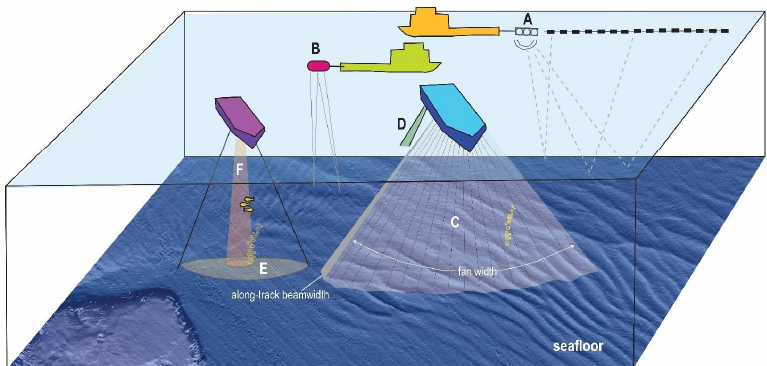
Figure 2. Schematic diagram showing high-resolution geophysical (HRG) and oceanographic sources. (A) HRG seismic sources such as boomers, bubble guns, and sparkers are towed behind a ship, with impulsive signals received on a streamer of receivers or on ocean bottom receivers. Air- guns, which are not an HRG source, are deployed in a similar way and are not shown here. (B) Towed subbottom profilers (SBP) transmit signals and receive acoustic returns in the same instru- ment package and are intermittent, non-impulsive sources that are not considered to be seismic sources. (C) Multibeam echosounders (MBES) detect seafloor depth and roughness and water col- umn anomalies (like the bubble plume shown in yellow), transmitting sound in a fan that forms a swath extending on either side of the vessel. This MBES system is hull-mounted, but MBES can also be deployed in other geometries or on remote vehicles. (D) Schematic of one of the four transpond- ers of a typical hull-mounted acoustic doppler current profiler (ADCP), whose narrow beams are aimed at 20–30° from the vertical [22] . (E) A hull-mounted SBP system ensonifies a cone below the vessel and can image tens of meters into the seafloor in some settings. (F) A fisheries split-beam echosounder (SBES) such as the EK60/EK80 (e.g., [23] ) detects water column anomalies such as fish, biological scatterers, and gas bubbles in a narrow cone using transducers of different frequencies. Not shown are sidescan sonars (SSS), devices using acoustic releases or locators, and communica- tion/tracking acoustics.